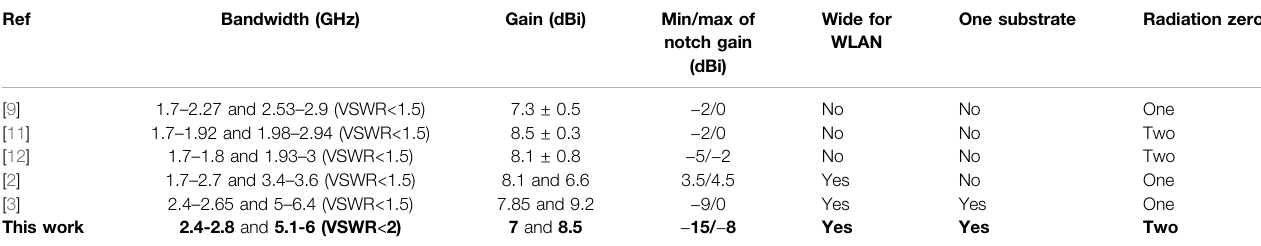
TABLE 1 | Comparison of different